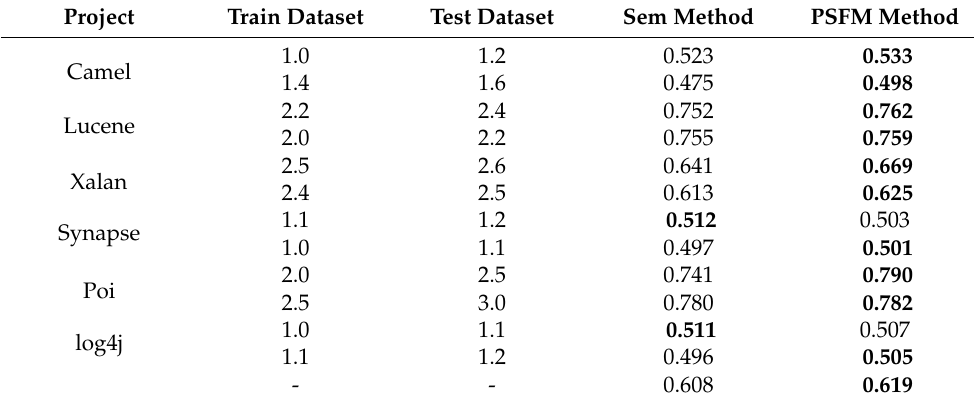
Table 3. F-measure comparison of the Sem method and PSFM